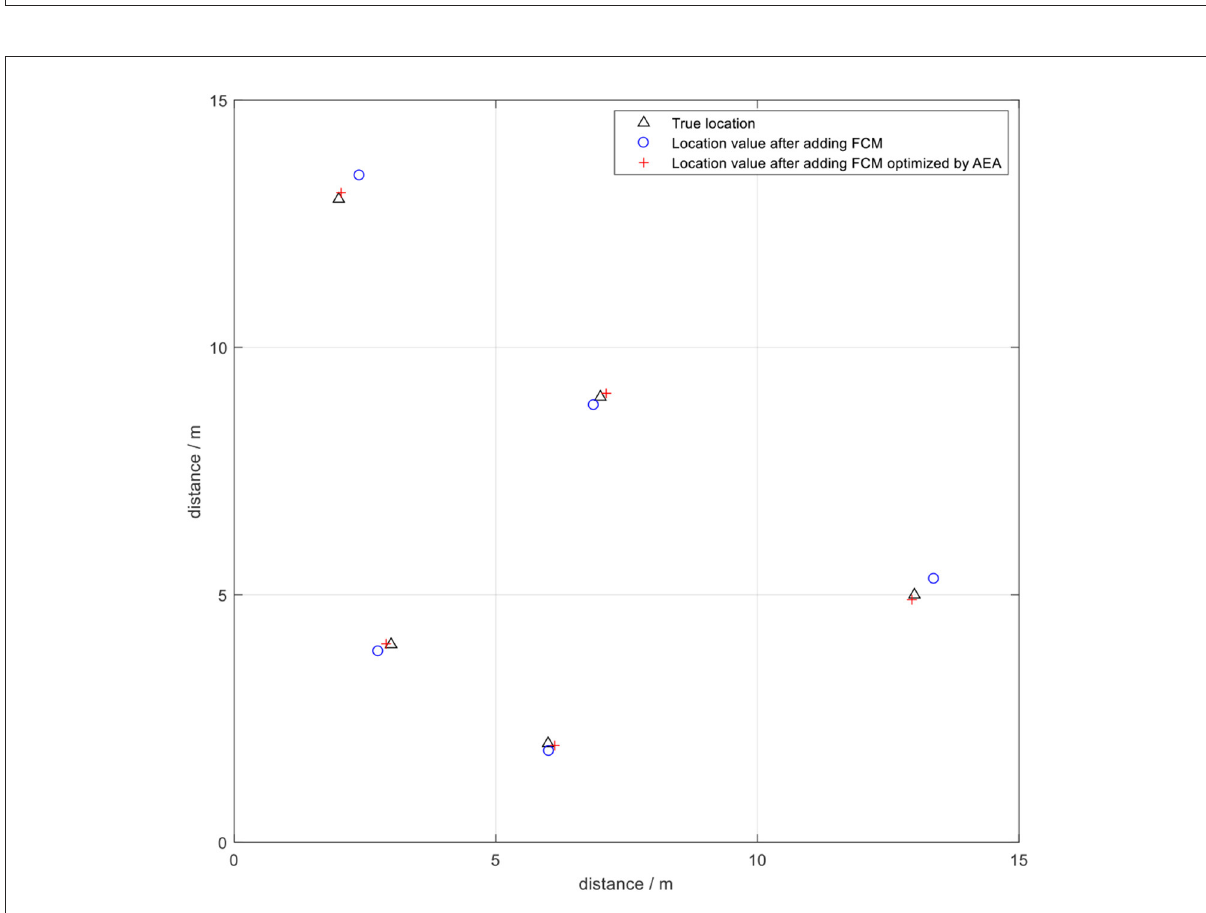
FIGURE14 Schematic diagram showing the static